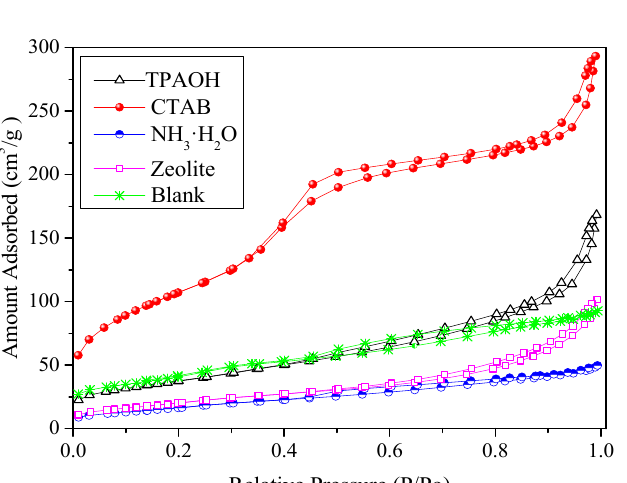
Figure 3. The N 2 adsorption–desorption isotherm of Cu-Al/SiO 2 porous materials with different templates (Blank, TPAOH, CTAB, NH 3 · H 2 O, and Zeolite were used, respectively, instead of the Cu-Al / SiO 2 porous materials with no template added, tetrapropylammonium hydroxide (TPAOH), cetyltrimethylammonium bromide (CTAB), ammonium hydroxide (NH 3 · H 2 O), and zeolite seed crystal).